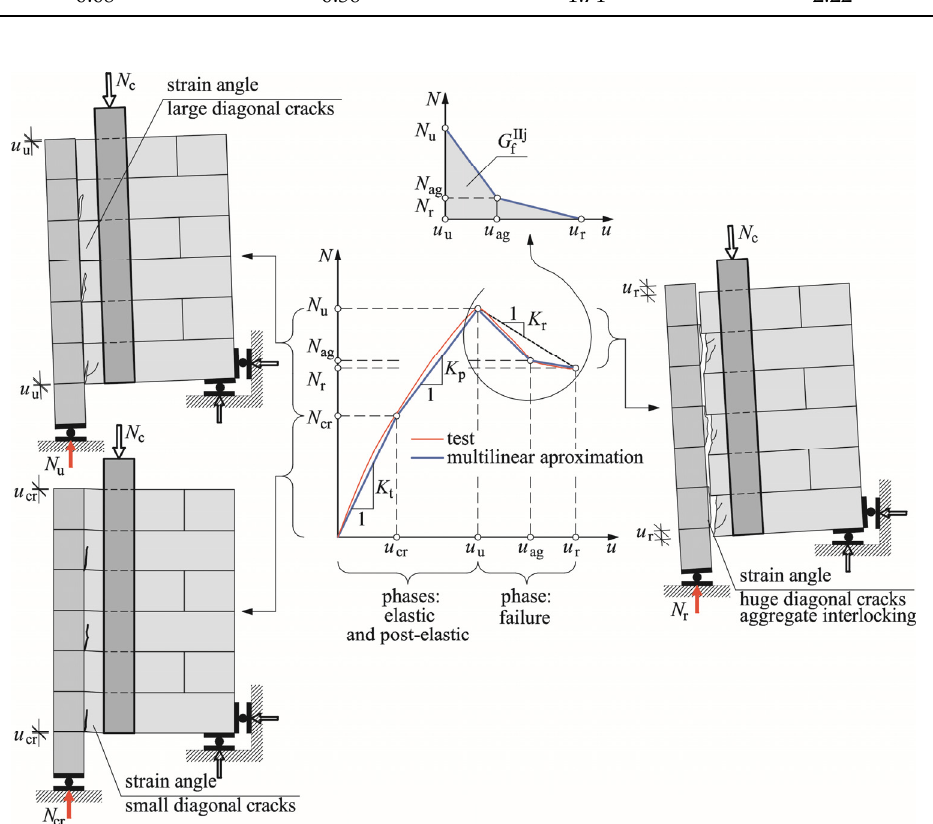
Figure 6. Approximation of work of unreinforced joints between masonry walls.